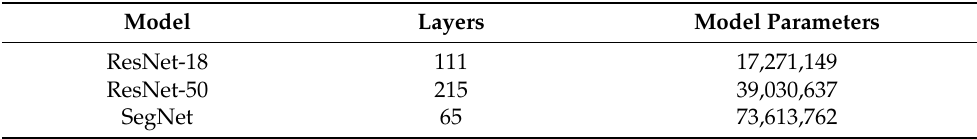
Table 4. Layers and model parameters of all three models.